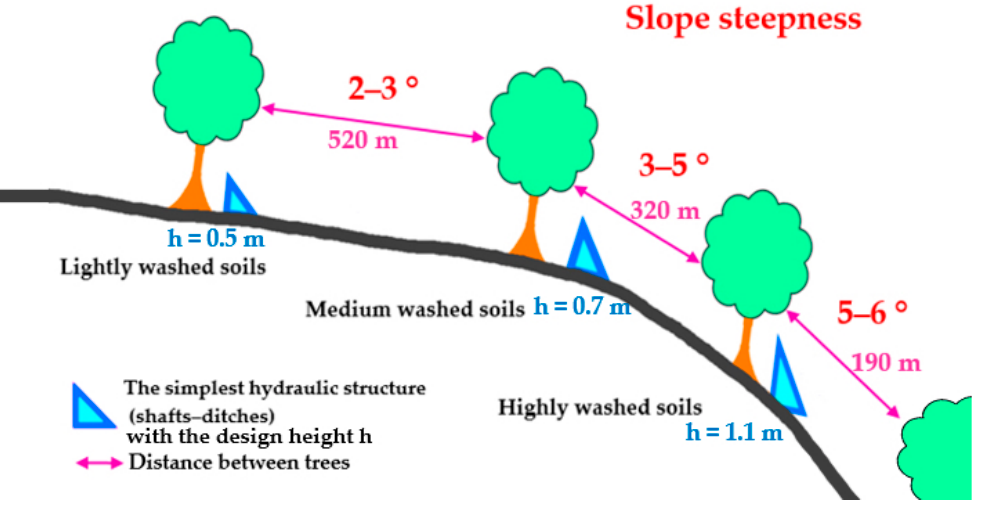
Figure 3. Erosion control of the slope with protective forest plantations and hydraulic structures.